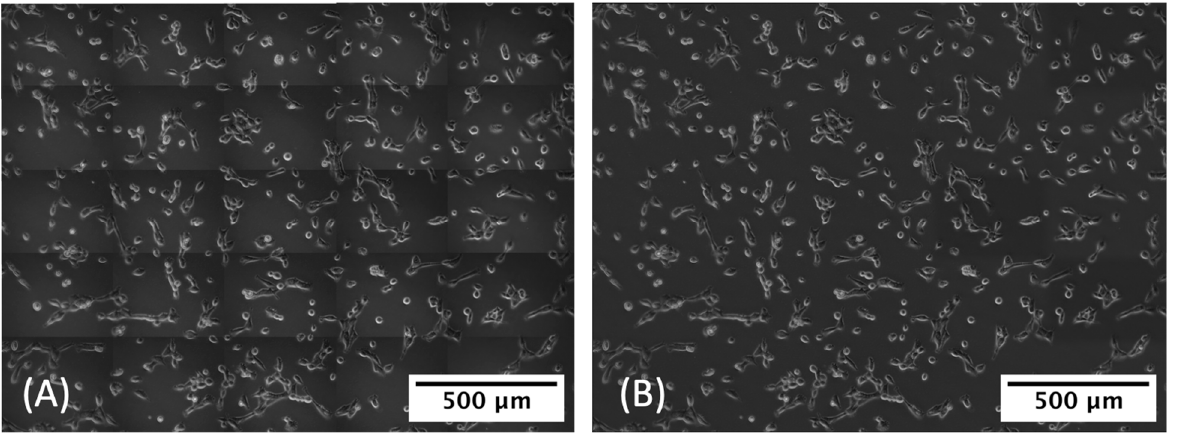
Figure 2. ( A ) Tiled image with shadows at edges of the tiles and ( B ) the same image with the shadows removed to prevent a high false-positive detection rate.